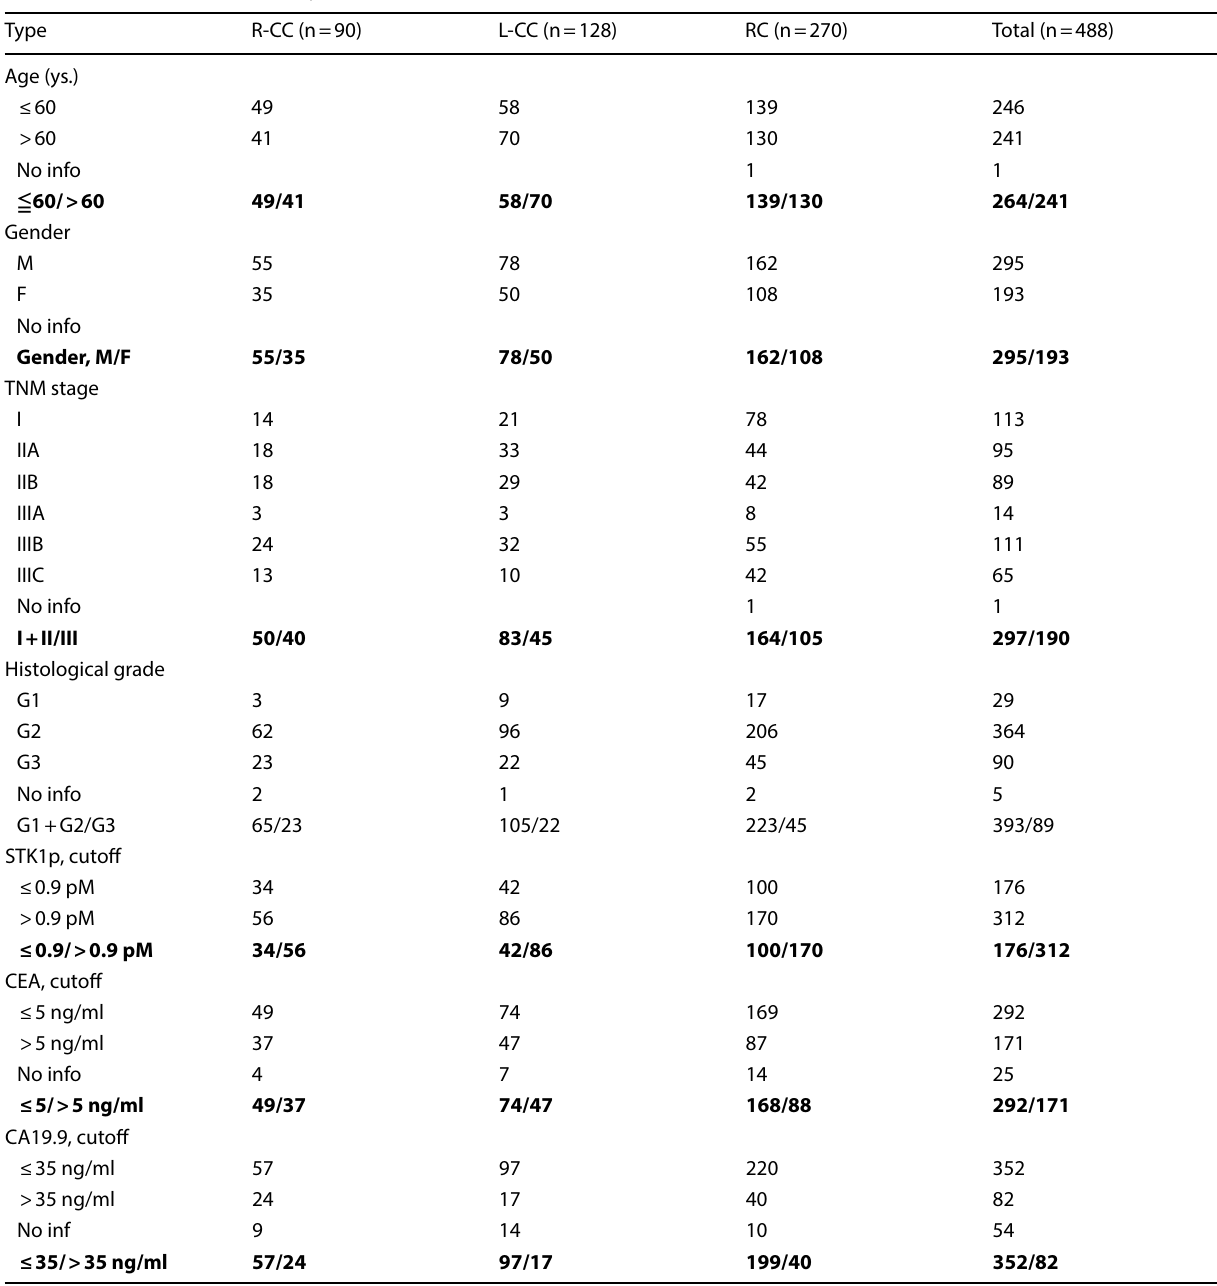
Table 5 PTL characteristics of CRC